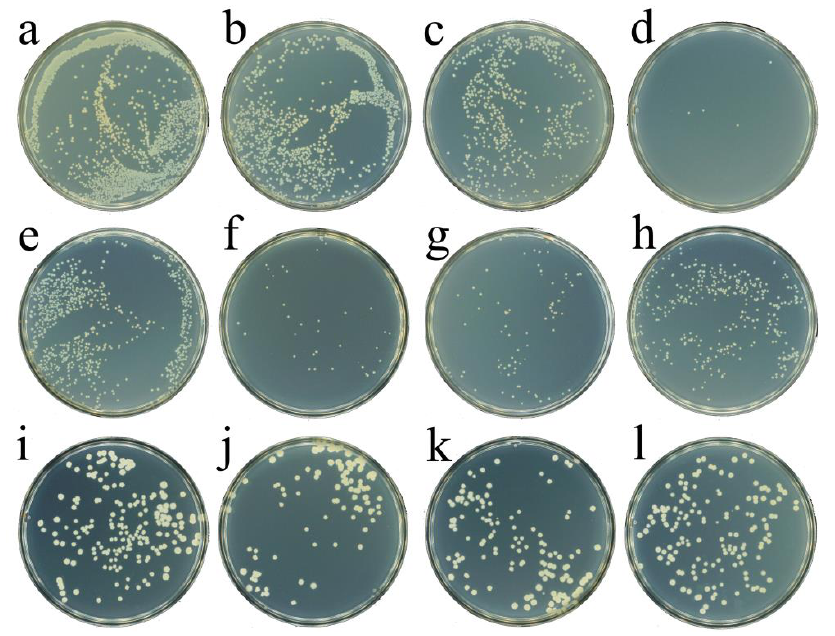
Figure 4. Photographs of bacterial colonies formed by E. coli and B. subtilis with different treatment at room temperature for 2 h. ( a ) E. coli ; ( b ) E. coli + 0.25 mg/mL CeO 2 ; ( c ) E. coli + 0.5 mM H 2 O 2 ; ( d )